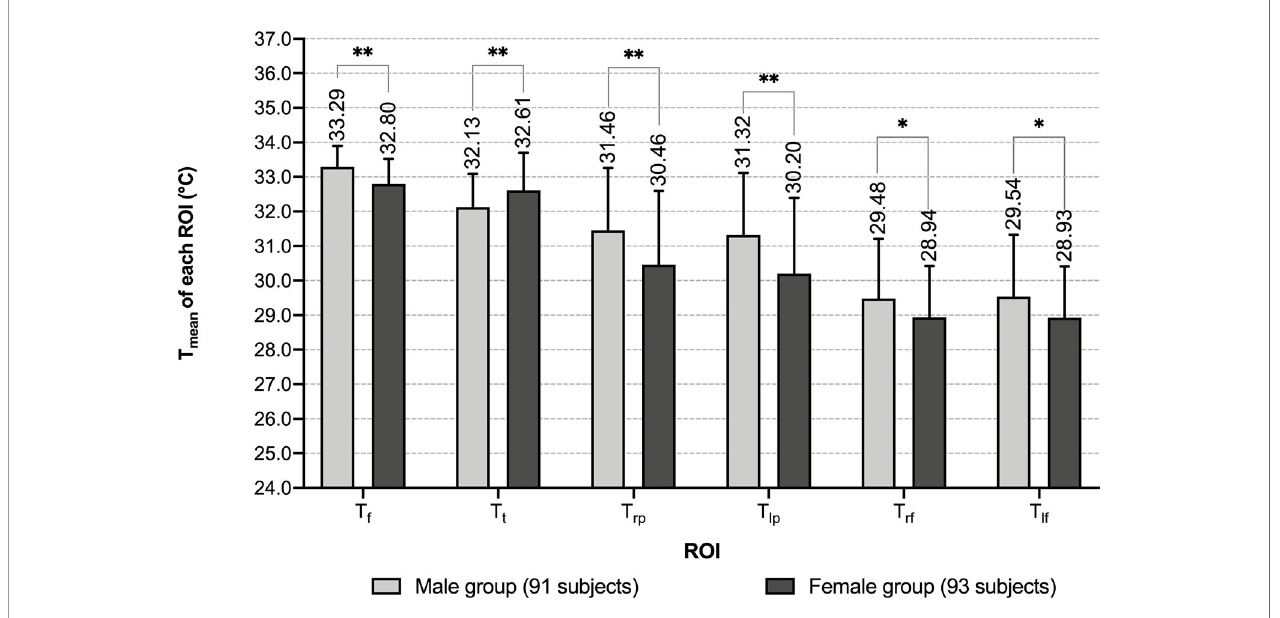
FIGURE 3 | Comparison of T mean of each ROI between different genders. *: P < 0.05 **: P <